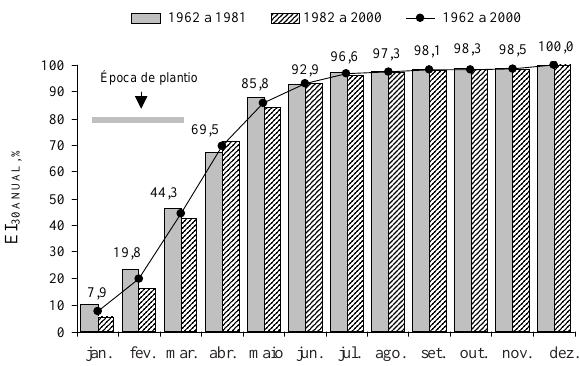
Figura 3. Distribuição percentual acumulada do índice de erosividade EI nos períodos de 1962 30